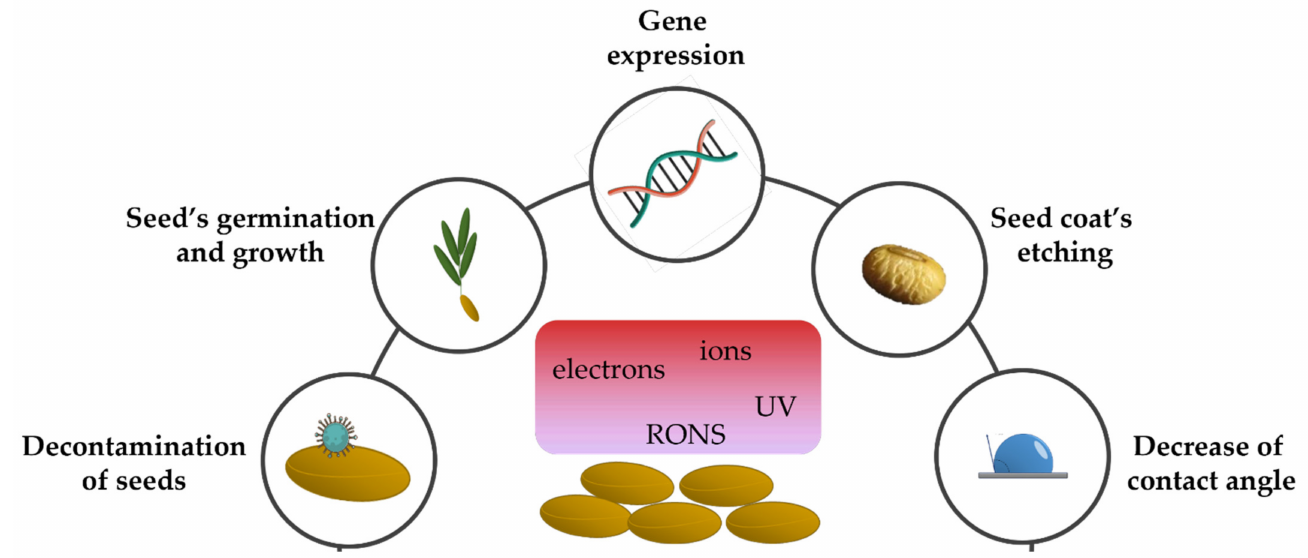
Figure 1. Cold plasma treatment on seeds influences decontamination, germination and growth processes, modulation of gene expression, seed coat’s etching and the decrease of contact